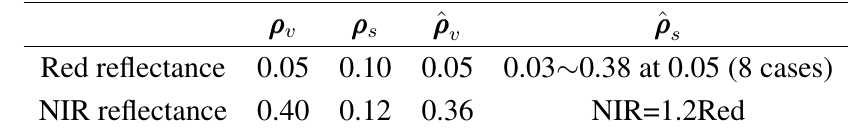
Table 4. True endmember spectra for the vegetation ( ρρρ (over a target field), and assumed endmember spectra for vegetation ( ˆ ρρρ ( ˆ ρρρ ) surfaces in the FVC retrieval algorithm during the numerical v